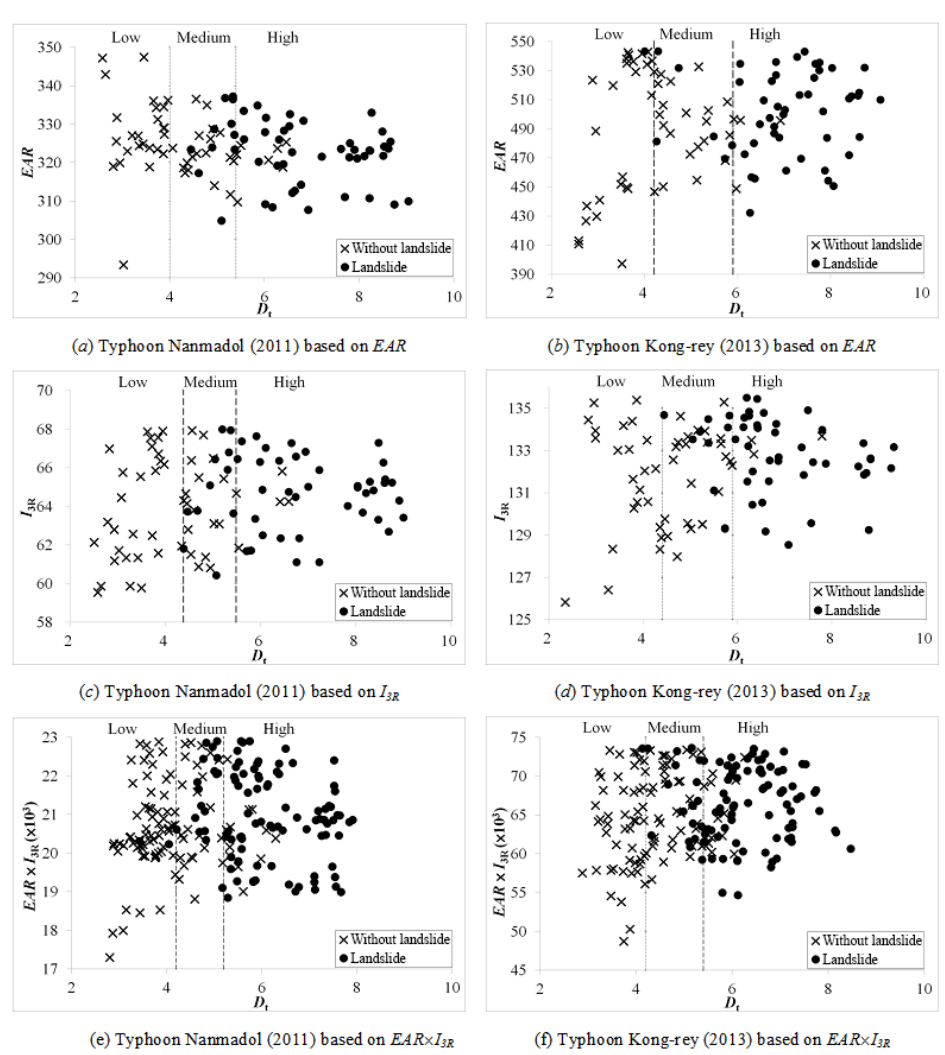
Figure 5. Relationships among instability index, effective accumulated rainfall, and landslide occurrence in the study area after typhoons Nanmadol (2011) and Kong-rey